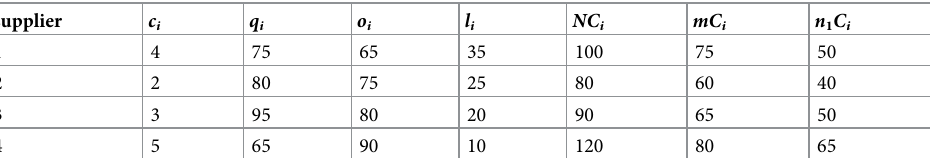
Table 2. Supplier quantity